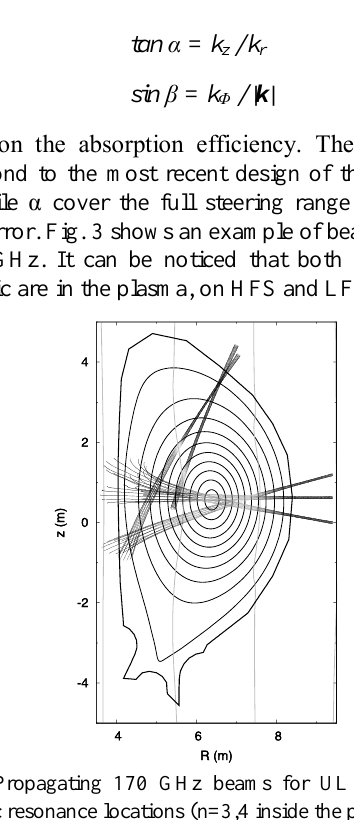
Fig. 1. T e and n e profiles for B 0 =1.8T scenario .